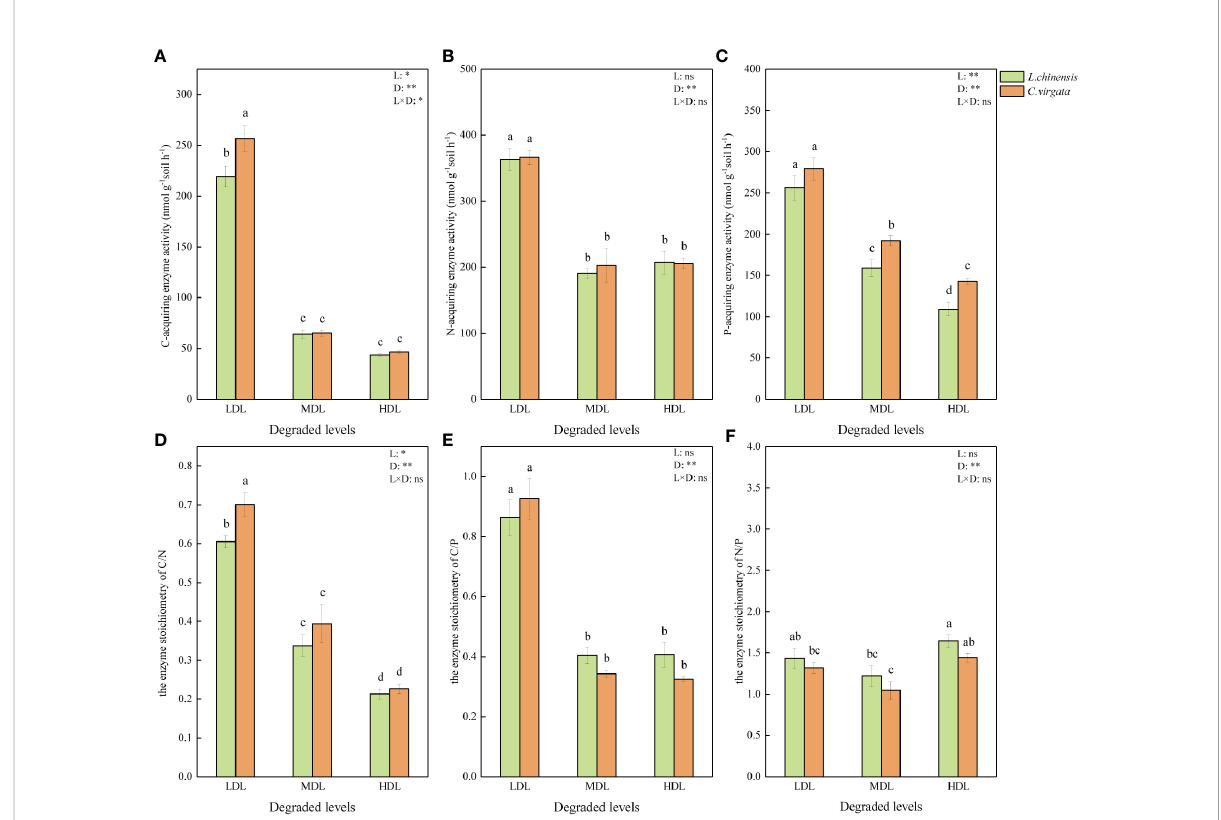
FIGURE 1 Soil extracellular enzyme activity (nmol g − 1 soil h − 1 ) and stoichiometry under in fl uence of different litter types at different degraded levels. (LDL, lightly degraded level; MDL, moderately degraded level; HDL, highly degraded level; L. chinensis , Leymus chinensis ; C. virgata , Chloris virgata . (A) C- acquiring enzyme activity; (B) N-acquiring enzyme activity; (C) P-acquiring enzyme activity; (D) the enzyme stoichiometry of C/N; (E) the enzyme stoichiometry of C/P; (F) the enzyme stoichiometry of N/P. Different letters represent signi fi cant differences among means at P <